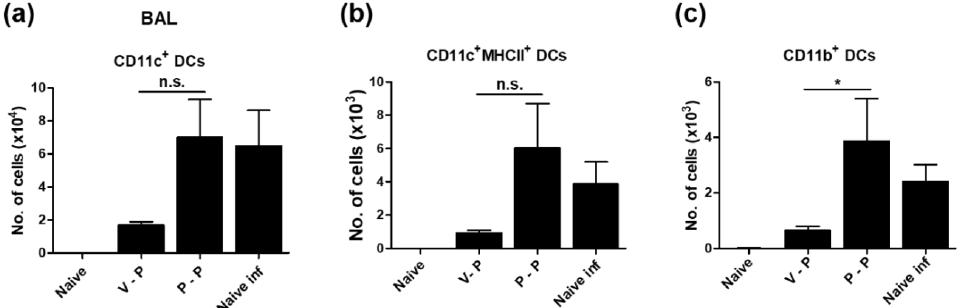
Figure 5. VLP-primed mice show lower levels of infiltrating dendritic cells after virus challenge. The cells obtained from BALF at 6 dpi (A/Phil, H3N2) were stained with anti-CD11c, CD11b, MHCII, CD45 to determine dendritic cell subtypes by flow cytometry. Each DC subtype was gated from the pre-gated CD45 + F4/80 - cells. ( a , b ) Total CD11c + DCs and activated DCs (CD11c + MHCII + ). ( c ) CD11b + DCs gated from CD11c + MHCII + DCs. The group labels are the same as in the Figure 3. The statistical significance was confirmed by one-way ANOVA and Dunnett’s multiple comparison test. Error bars indicate the means ± SEM of concentrations from individual animals. *; p < 0.05. n.s.; no significance.